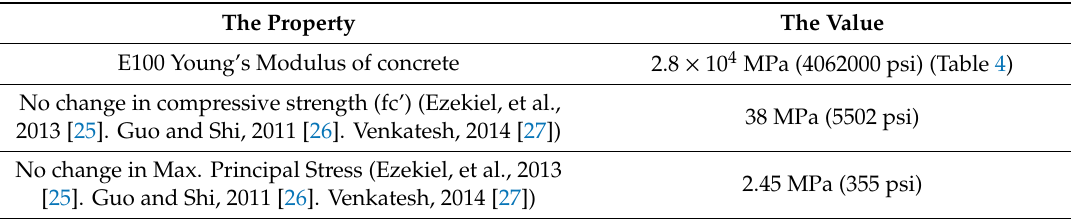
Table 5. Concrete Properties at 100 ◦ C.